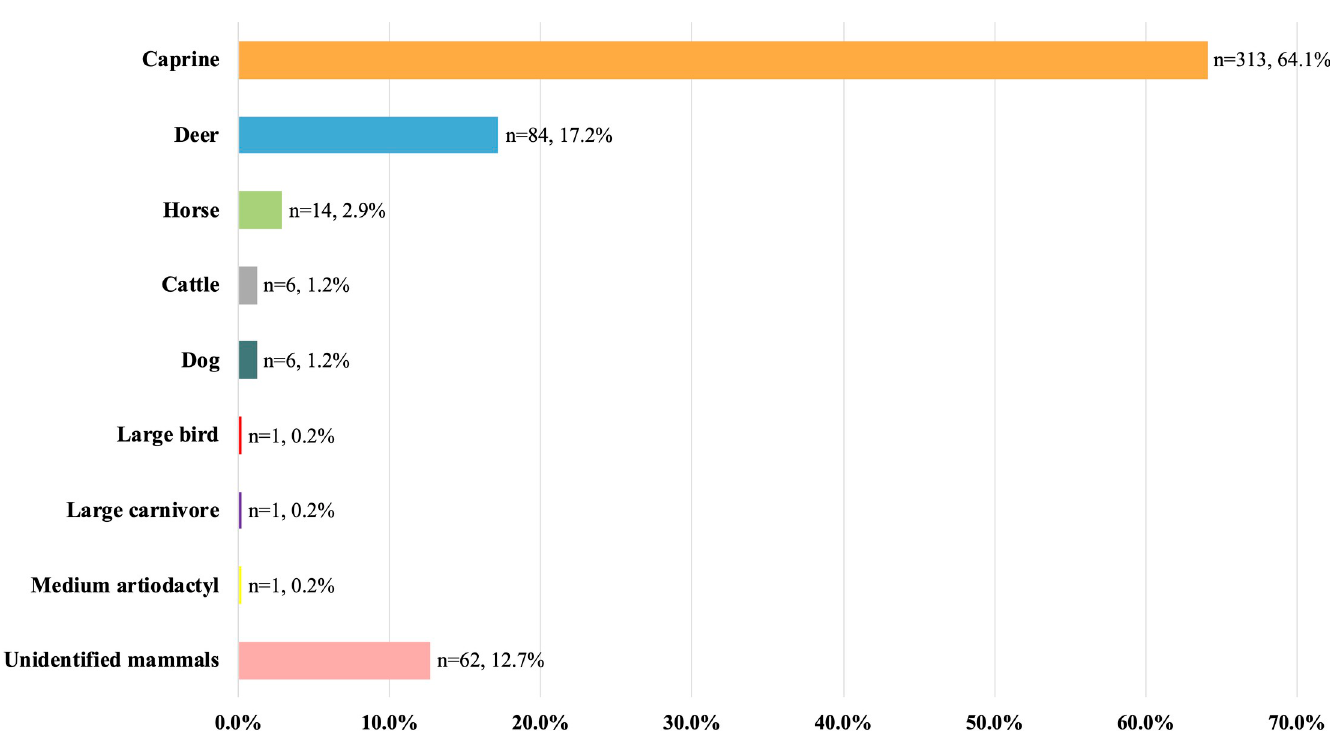
Fig 13. Animal taxonomic structure for worked bones from